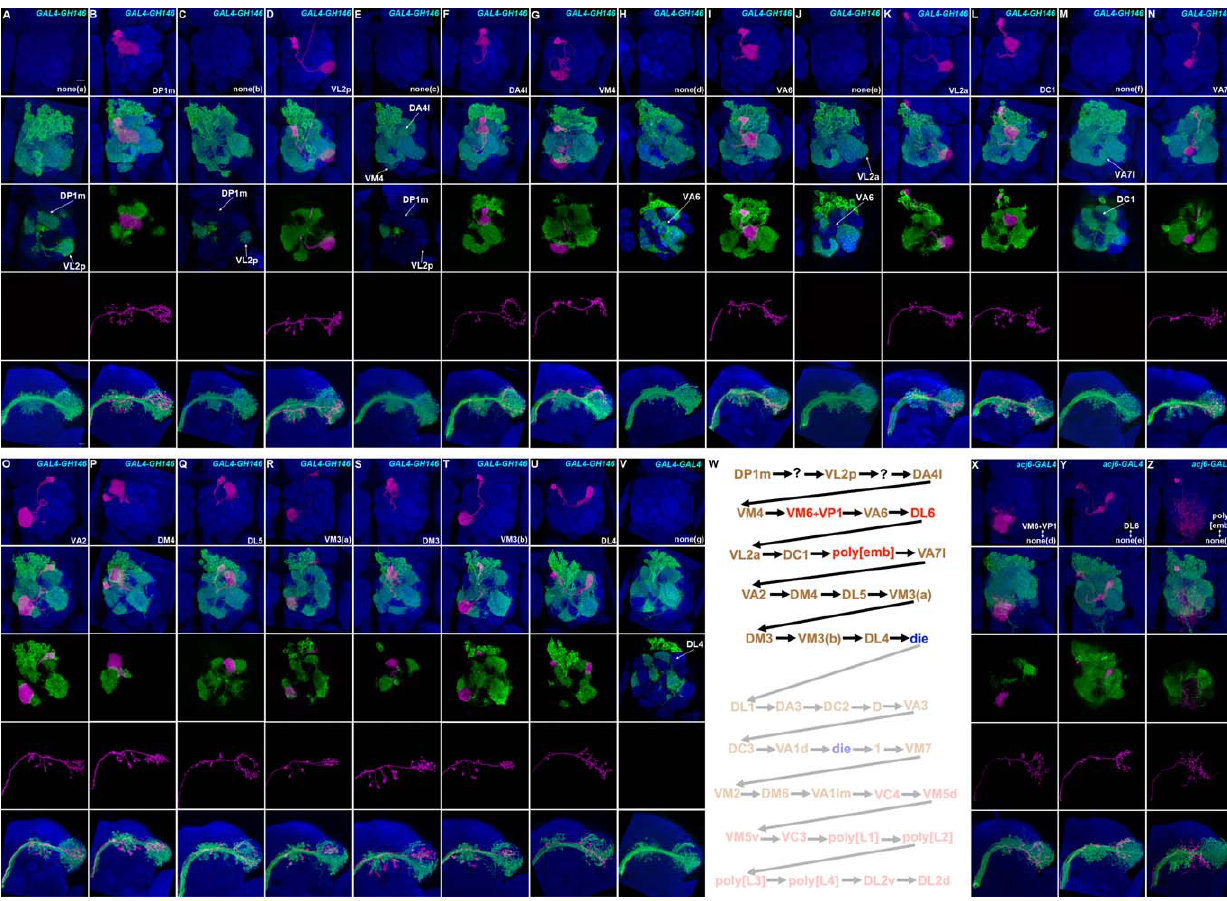
Figure 4. Eighteen types of embryonic-born adPNs. Embryonic-derived twin-spot clones labeled with GAL4-GH146 (A–V) or acj6-GAL4 (X–Z). Top two panels: composite confocal images of the AL showing single adPNs (magenta) and the paired NB clones (green); middle panels: single focal sections of the AL covering the glomerular targets of single adPNs; bottom two panels: axon projections of single adPNs (magenta) and the accompanying NB clones (green). 22 types of GH146-labeled NB clones can be distinguished and are shown in the order of decreasing complexity from (A) to (V). 15 of them pair with distinct adPNs while seven of them exist alone (no magenta labeling). The unpaired NB clones in (H), (J), and (M), when labeled with acj6-GAL4, were paired with novel GH146-negative adPNs, including one additional type of polyglomerular PN (X–Z). The sequence of embryonic-derived adPNs is shown in (W). Note presence of one neuron per type (except VM3-targeting PNs in [R] and [T]) in the lineage of primary neurons, as evidenced by the glomerular targets of single adPNs (magenta) not innervated by their accompanying NB clones